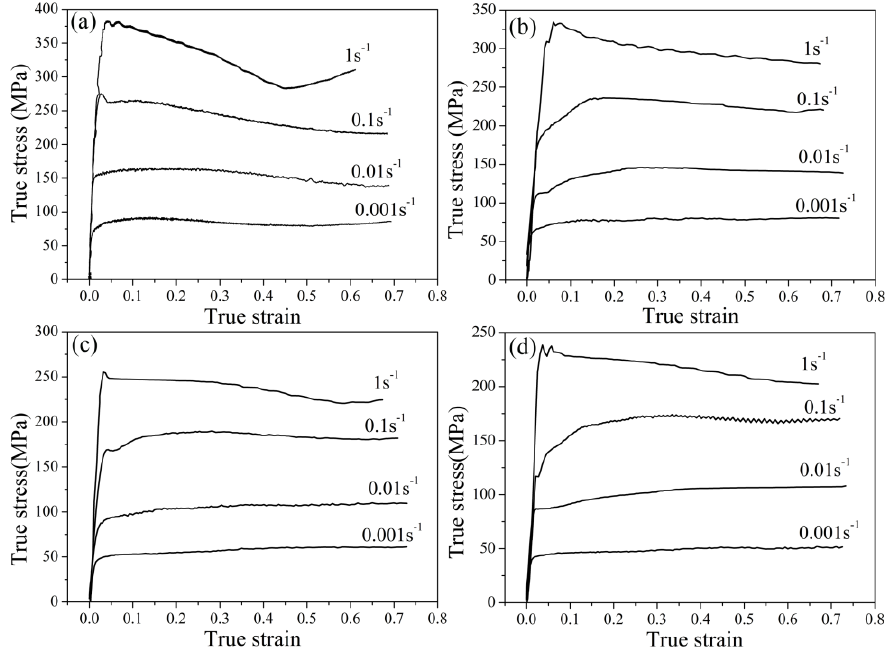
Figure 2. Compressive true stress- strain curves of the alloy under different temperature